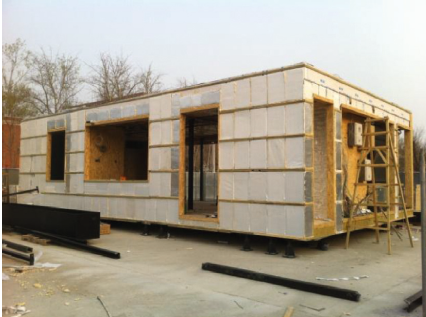
Figure 5: Building’s exterior wall with HIPs employed during the building process (source: authors’ own